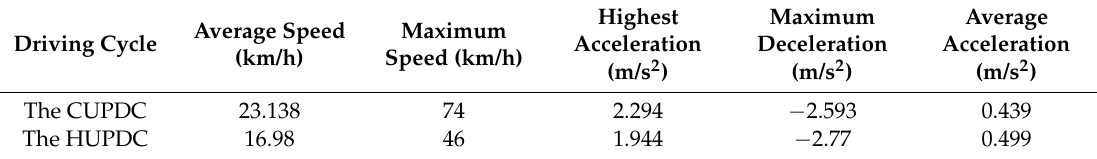
Table 1. Comparison of main characteristic values under two different driving